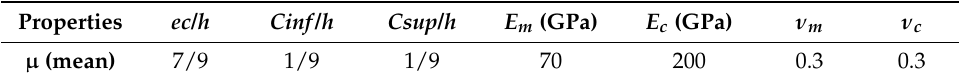
Table 9. Parameters mean values: case 3.2.2—Thicker